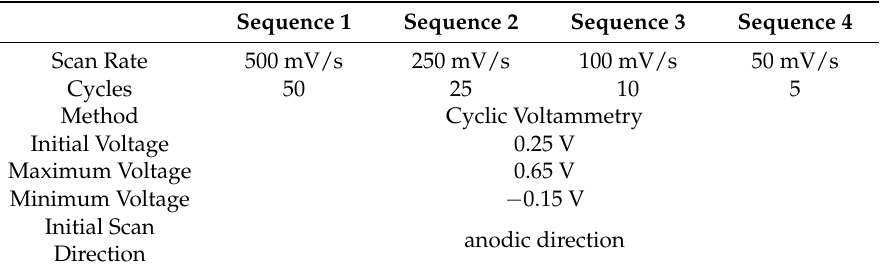
Table 1. Sequences for the surface activation on the